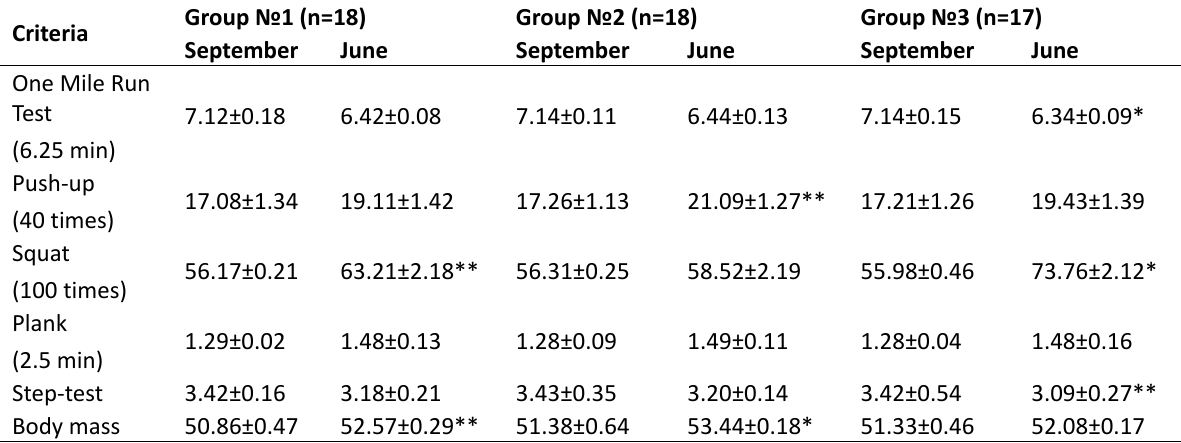
Table 1. The test results of female students for the period of research.